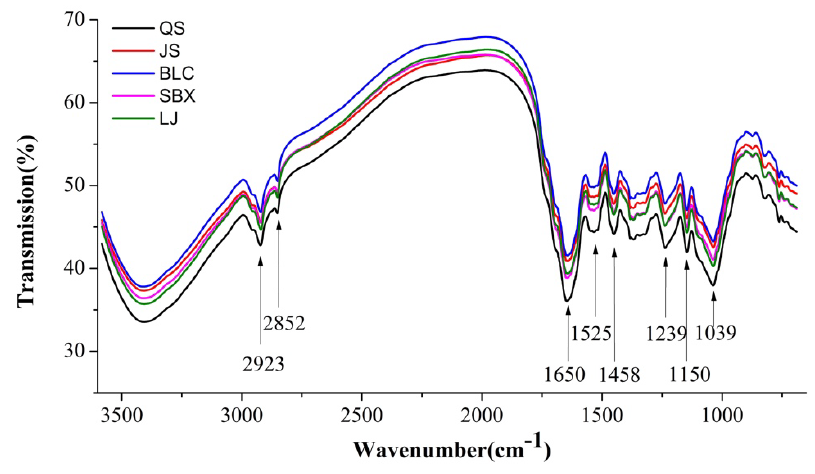
Figure 1. Averaged spectra of five green tea brands in the range of 3582–689 cm − 1 .